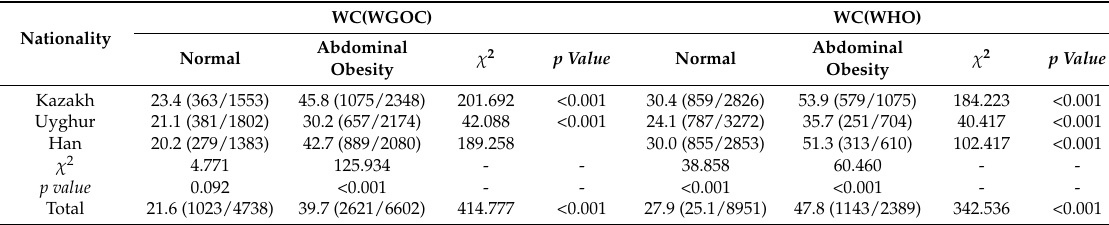
Table 5. Prevalence of hypertension by WC and nation.